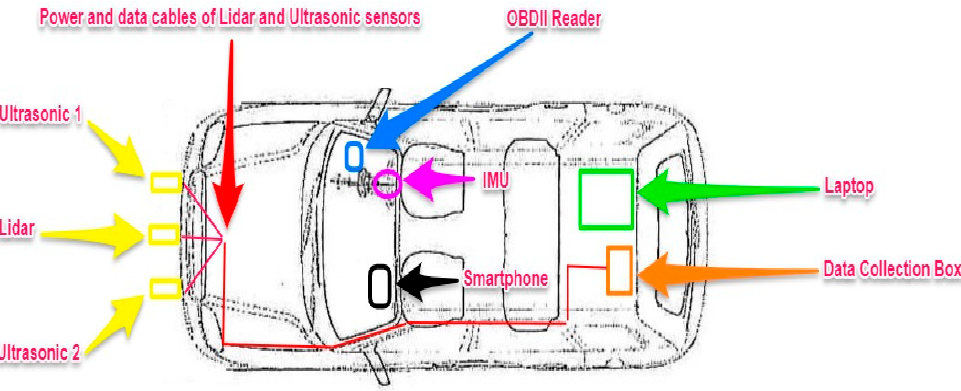
Figure 11. The architecture and design of the proposed DAS.